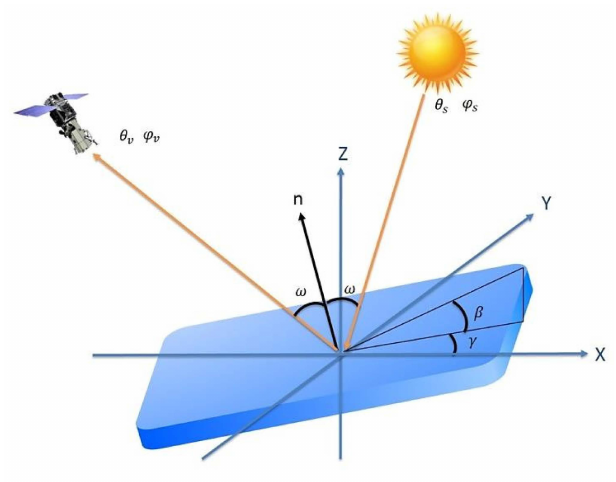
Figure 5. Specular reflection geometry on a flat